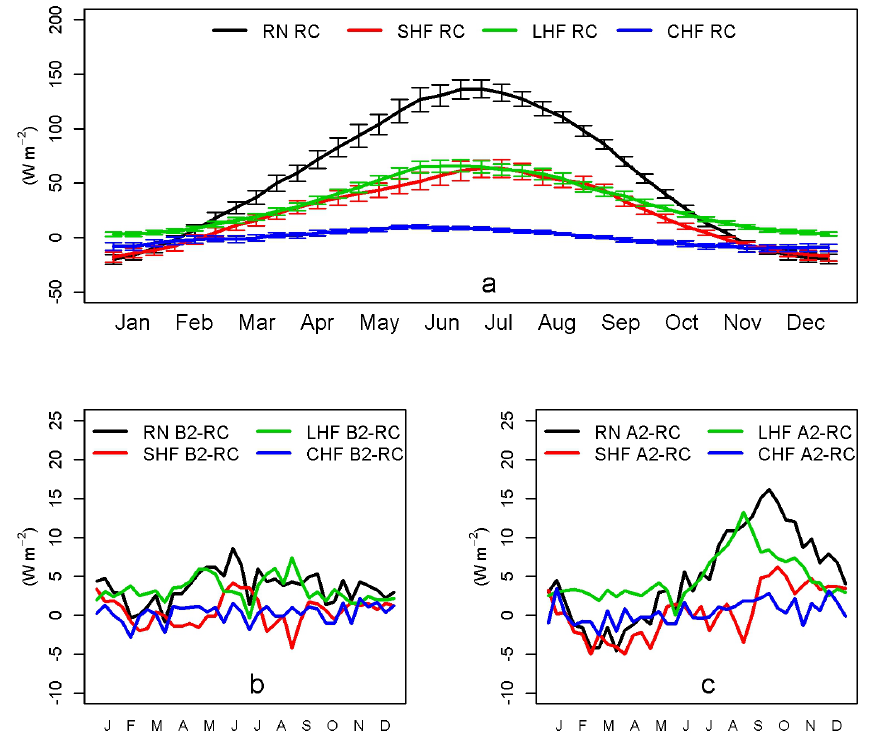
Figure 2. Annual cycles of the 10-day average values of the surface energy budget components for plains (i.e., grid points located below 500 m a.s.l.) for ( a ) RC (with standard deviations; vertical bars), ( b ) FC B 2 – RC, and ( c ) FC A 2 – RC. Here, NR is the net radiation, SHF is the sensible heat flux, LHF